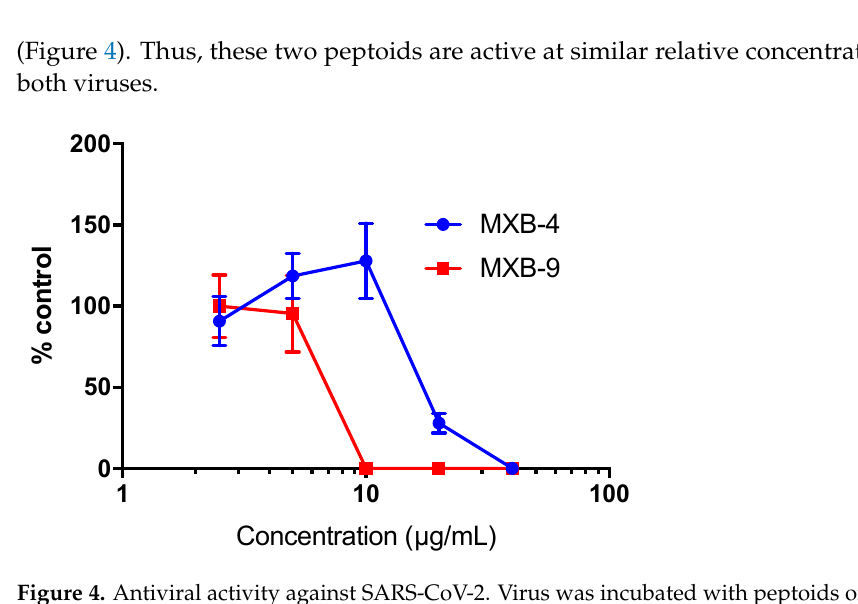
Figure 6. In vitro toxicity of peptoids. Peptoids were incubated on the apical surface of cultured EpiAirway cells ( n = 3 wells per concentration) for 3 h. Cell viability was quantified by MTT assay and are shown as mean percent survival +/ − SD. Results shown are representative of two inde- pendent replicate experiments. 3. Discussion Herpesvirus infections are common and easily transmissible. However, due to the mechanisms of infection and pathogenesis at play, it has been difficult to design any ef- fective vaccines to prevent herpesvirus infections. Furthermore, other preventive and pal- liative methods have been challenging to adapt to broad clinical use. Since AMPs such as LL-37 exhibit potent activity against HSV-1 [36], their potential as antiviral preventive or therapeutic agents is significant. However, direct introduction of these peptides has not 020 4060 80 100